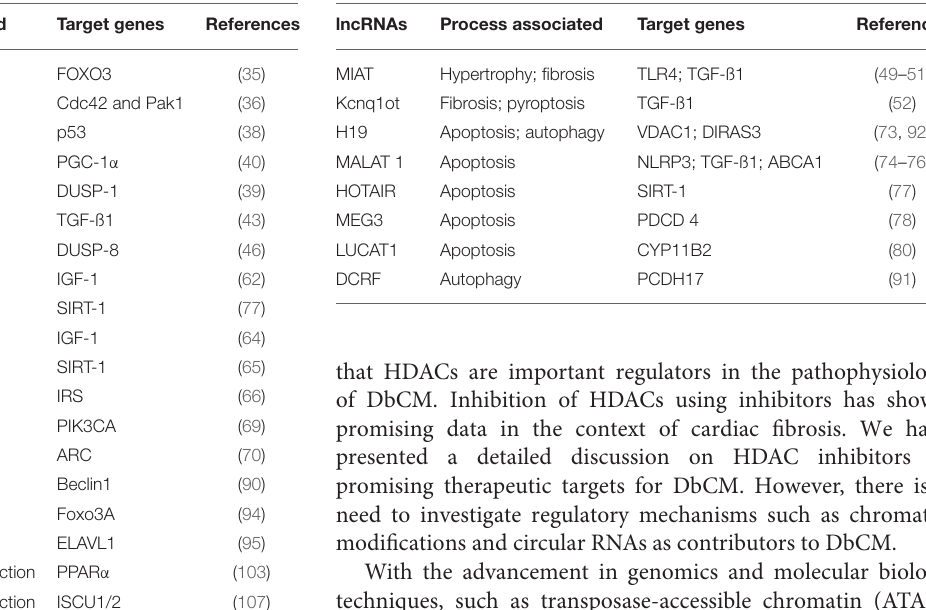
TABLE 1 | Deregulated miRNAs in diabetic cardiomyopathy (DbCM). TABLE 2 | Deregulated lncRNAs in